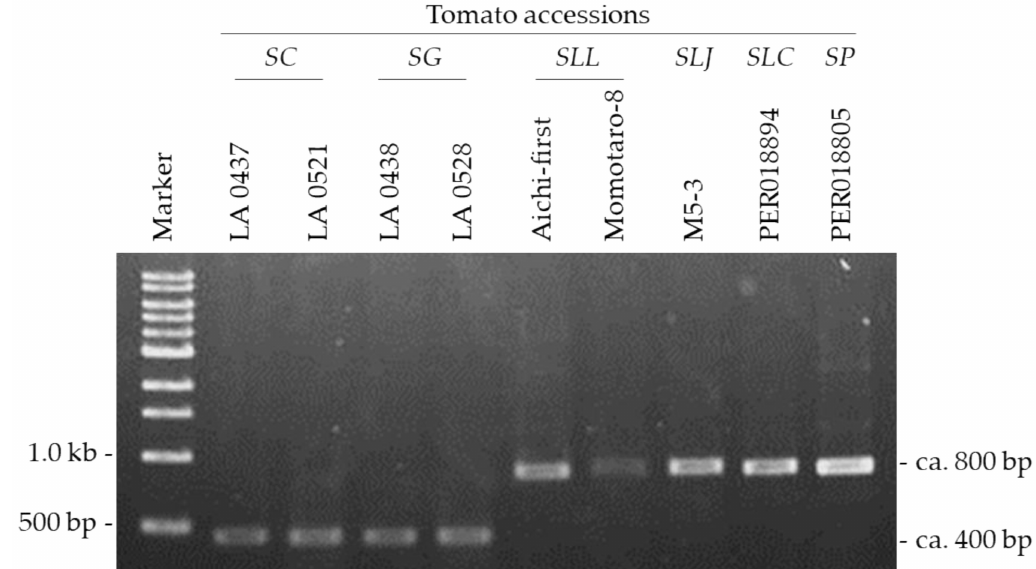
Figure 4. PCR amplification with the primer set F10+R10 (Table 2) to detect the ca. 400-bp deletion including the 5 (cid:48) -UTR and part of the 5 (cid:48) ORF of Asc1 (Figure 3). Only the reference accessions of SC and SG had the ca. 400 bp-deletion and none of the tested SP , SLC , and SLJ accessions had the deletion. In this figure, only representative accessions of SP , SLC , and SLJ are presented. Marker, 1 kb DNA Ladder (New England Biolabs, Ipswich, MA,